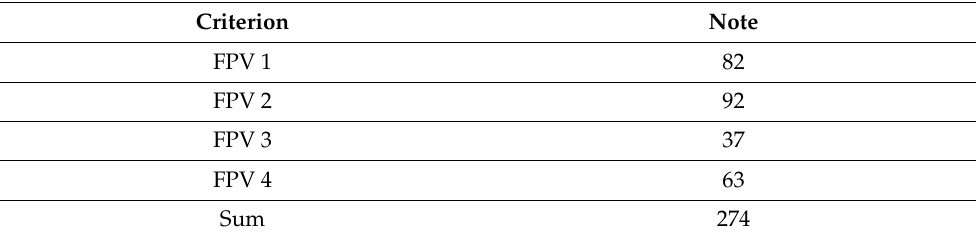
Table 7. Points obtained by the criteria (FPVs).